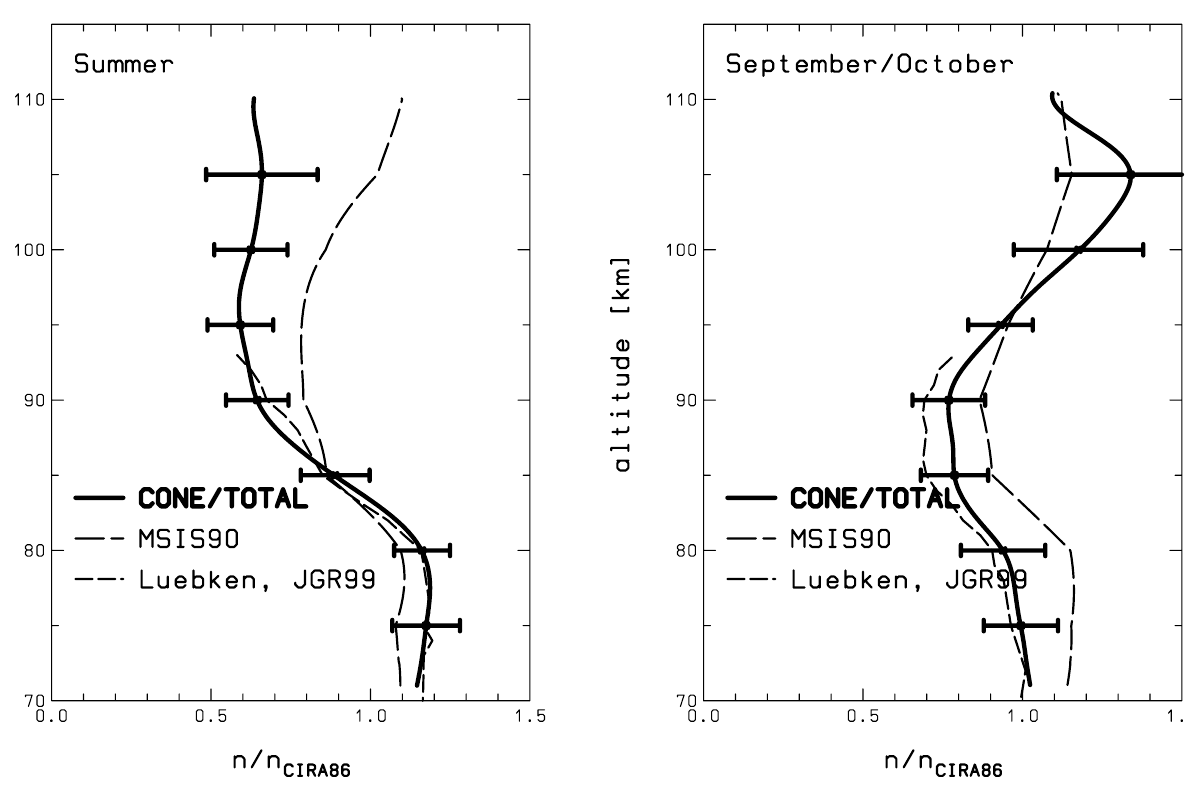
Fig. 9. Comparison of ionization gauge densities to density pro- files from MSIS90 (Hedin, 1991) and mean falling sphere densities (L¨ubken, 1999) for the core summer months July and August.